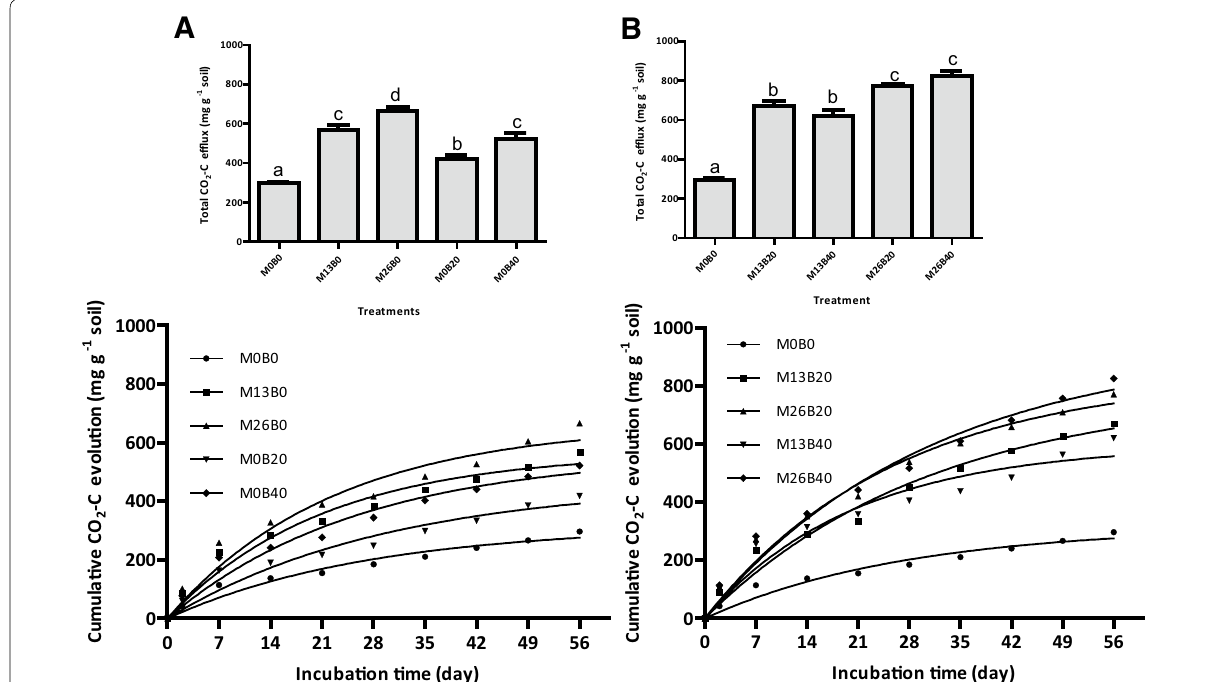
Fig. 1 Cumulative and total CO 2 efflux from incubation of soils amended with A sole manure (M) or biochar (B), and B M combined with B over 56 days. Insets show total CO 2 efflux. Same letter (s) above the bars indicate no significant difference between treatments at p represent standard error of the means (n 3). M0, M13 and M26 are M rate at 0, 13 and 26 tons ha − 1 , respectively. B0, B20 and B40 are B rate at 0, 20 = and 40 tons ha − 1 ,